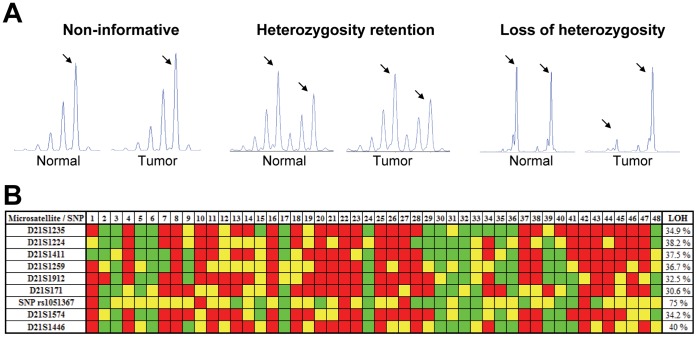
Analysis of LOH at 21q22.3 in lung cancer patients.Genomic DNA from primary lung cancers and their corresponding normal lung tissues were used. A) Representative examples of the electrophoretic patterns obtained by microsatellite analysis: a non-informative case, with only one amplification peak; heterozygosity retention, with two peaks in both normal and tumor samples; and LOH, with two peaks in the normal sample but only one peak in the corresponding tumor sample. Arrows point to microsatellite alleles. B) LOH of the indicated microsatellites was analyzed in 48 NSCLC patients. Microsatellites are ordered from the most centromeric to the most telomeric. LOH at the ADAR2 locus was analyzed by direct sequencing of the polymorphism rs1051367 (A/G). Green boxes represent LOH, red boxes indicate retention of heterozygosity, and yellow boxes are non-informative loci.